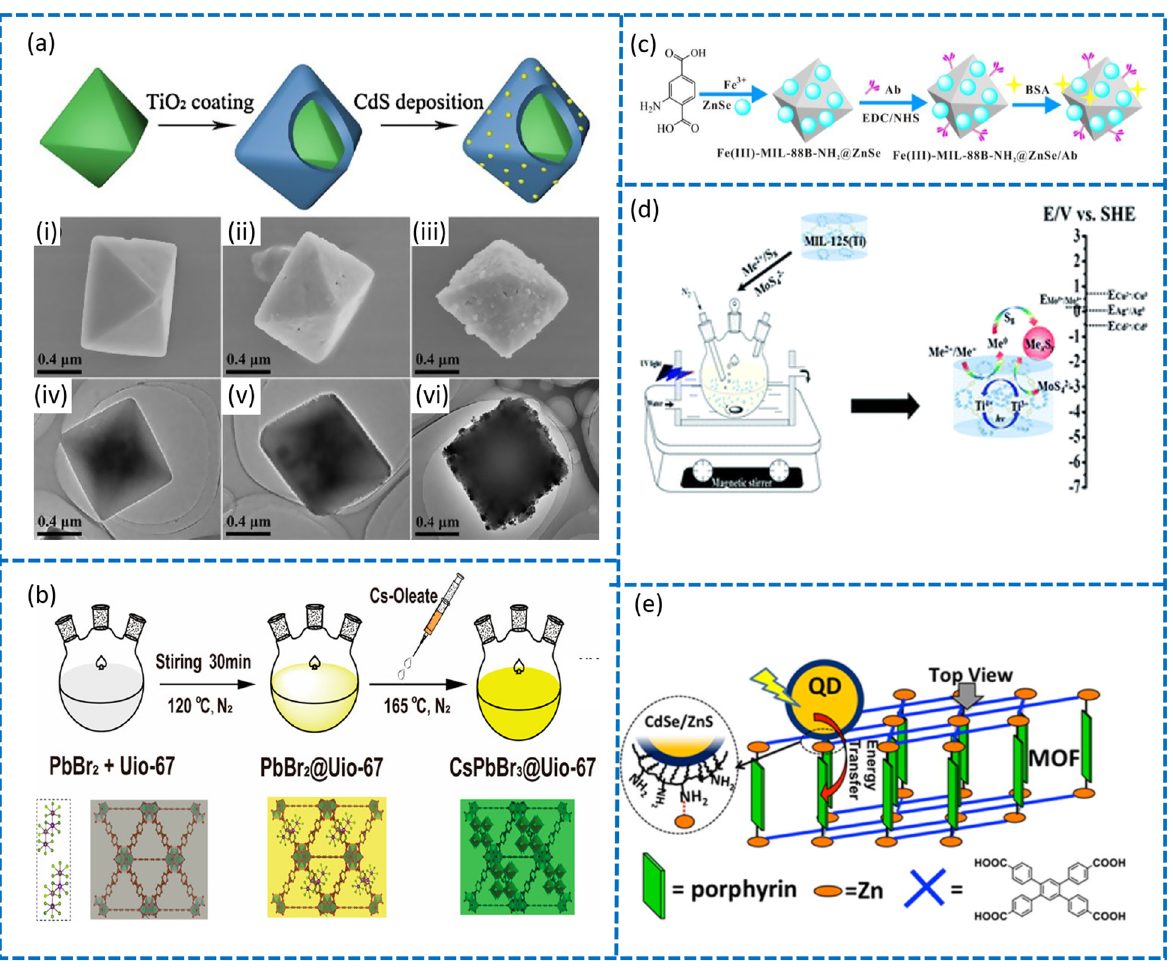
Figure 3: ( a ) Graphical representation of the construction of CdS/NH 2 - MIL - 125@TiO 2 and corresponding SEM and TEM images [ 107 ] . ( b ) Designed fabrication strategy for CsPbBr 3 @Uio - 67 composite formulation and accompanying structural diagrams [ 109 ] . ( c ) Synthesis scheme for CdS/NH 2 - MIL - 125@TiO 2 and antibody detection [ 112 ] . ( d ) Diagrammatic representation of the mechanism for photodeposition of Me x S y on MIL - 125 ( Ti ) [ 114 ] . ( e ) Illustrative representation of porphyrin - established MOFs with CdSe/ZnS core/shell QDs [ 116 ]